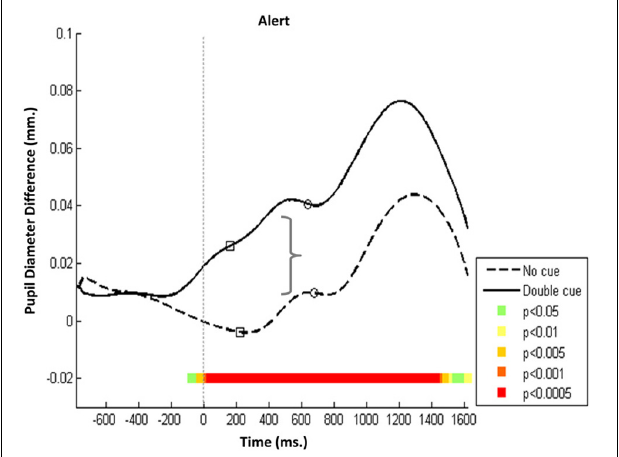
FIGURE 2 | Alerting network—Mean PD dilation. Blue line, no cue trials; black line, double cue trials; white squares, mean entrance to target AOI; white circles, mean button press. Time zero represents target onset (dashed gray line) and − 500ms cue onset (dotted gray